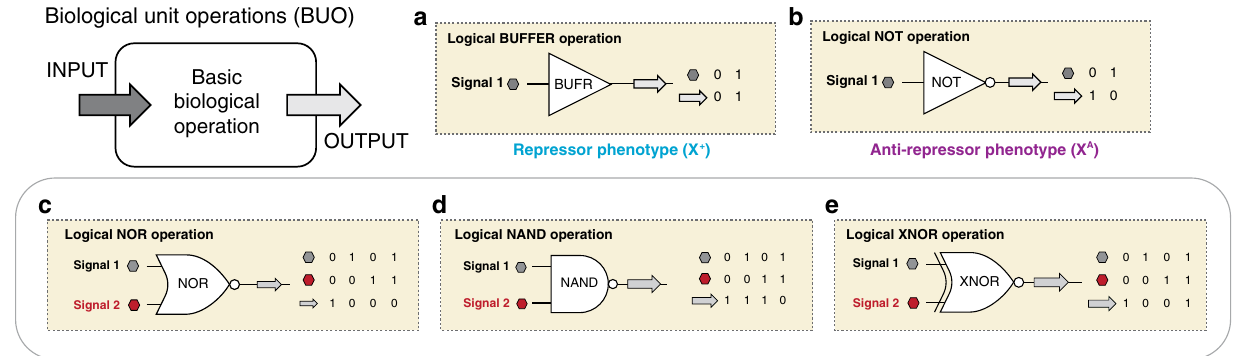
Fig. 1 De fi ning biological unit operations (BUO). Similar to a unit operation in chemical engineering, a biological unit operation is a discrete process unit that converts an INPUT to a predictable OUTPUT, within a given performance boundary. A summary of biological Boolean logical operations developed (or employed) in this study is as follows: a the foundational logical BUFFER operation (i.e., BUFFER BUO), executed by the repressor (X + ) phenotype. b The foundational logical NOT operation (i.e., NOT BUO), executed by the anti-repressor (X A ) phenotype. BUFFER and NOT are the fundamental BUO used